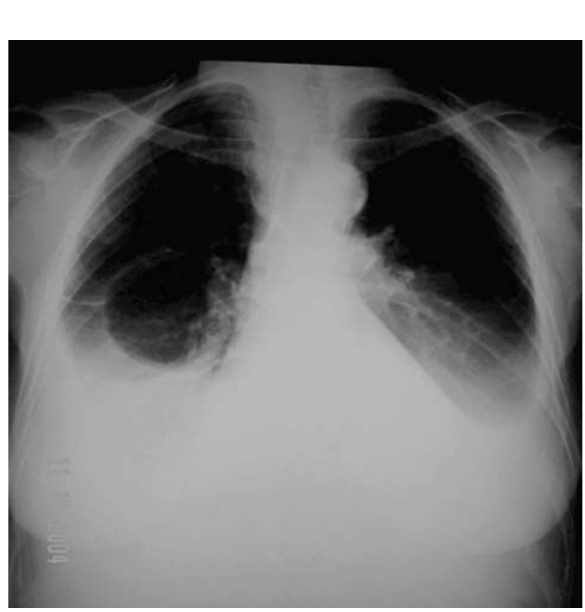
Figure 2 – Thorax x-ray showing bilateral pleural